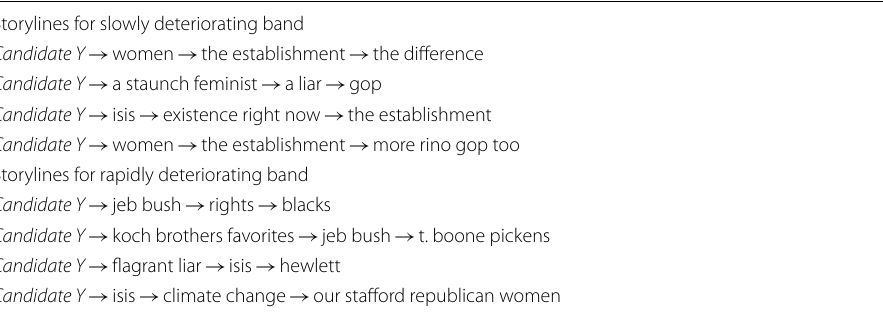
Table 4 Storylines for political candidate with the highest score for slowly and rapidly deterioration perception bands Storylines for rapidly improving band